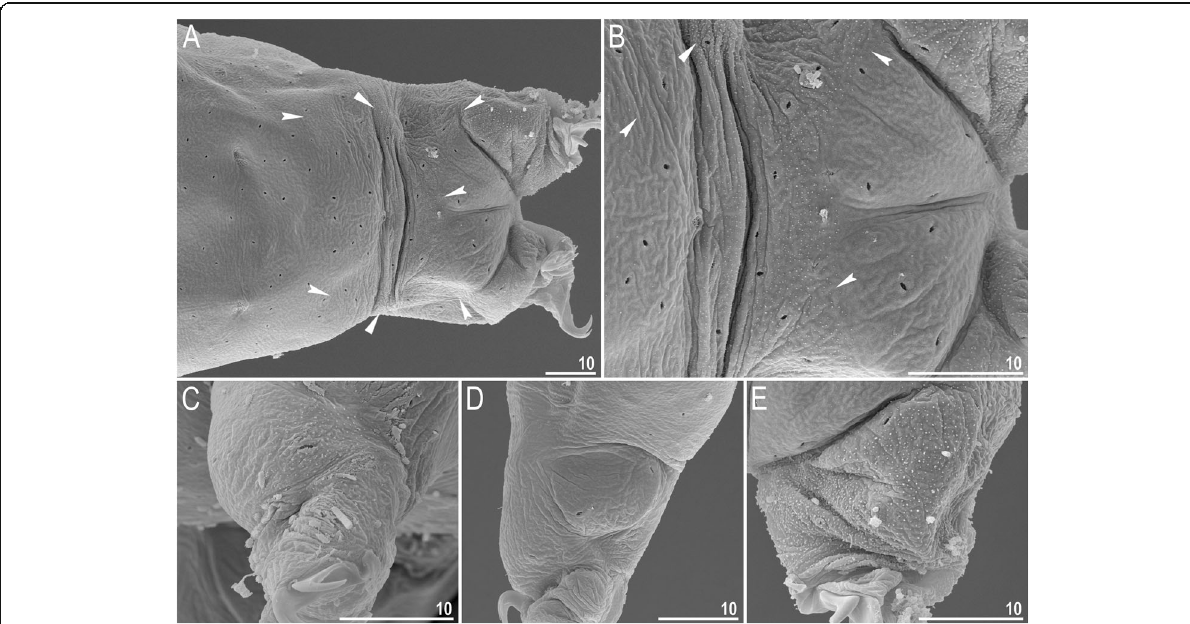
Fig. 14 Macrobiotus pseudopallarii sp. nov. from Montenegro (ME.007) – body and leg cuticle morphology seen with SEM: a – b – band of caudal granulation on the last body segment; c – granulation on the external surface of leg II; d – internal surface of leg II with evident pulvinus; e – granulation on dorsal surface of leg IV. Filled flat arrowheads indicate dense patches of granulation in the caudal band, filled indented arrowheads indicate sparse granulation in the caudal band. Scale bar in μ m